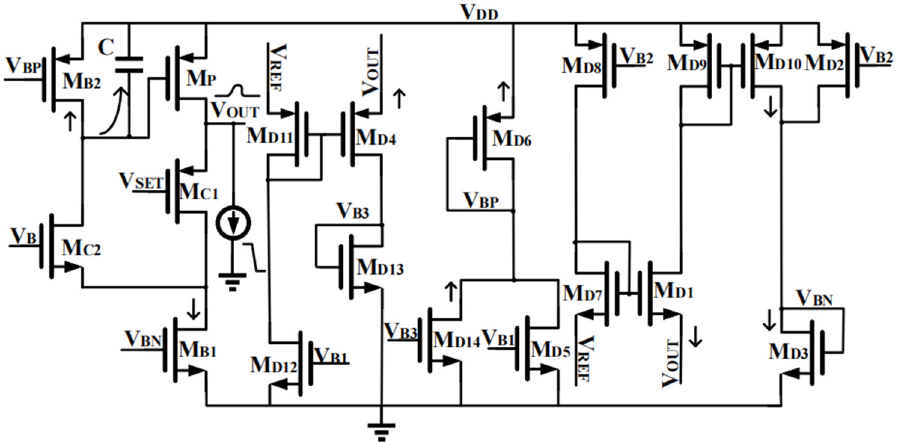
Figure 7. Signal response when I OUT decreases.